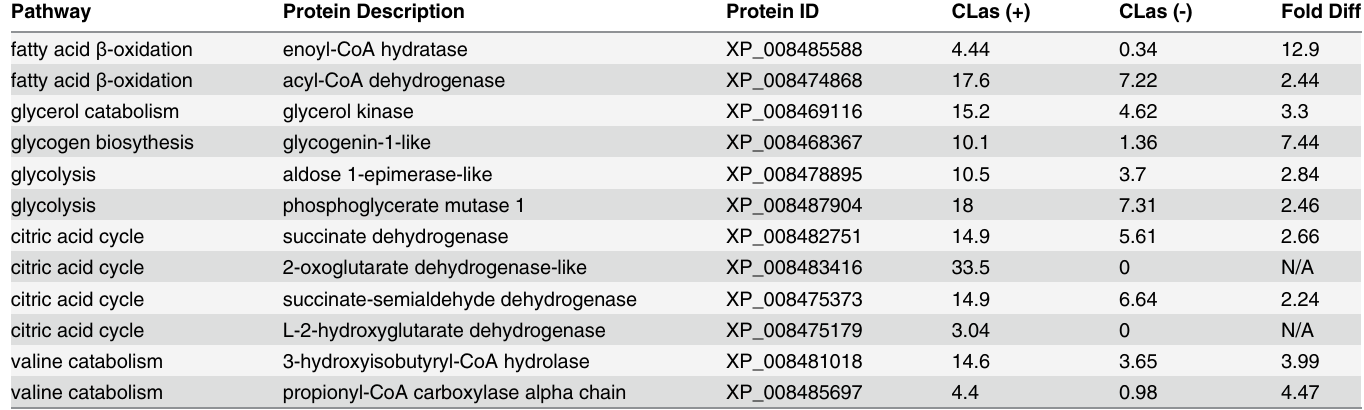
Table 2. Selected D . citri metabolism proteins upregulated in CLas(+) insects. Average normalized peptide count from specified proteins and fold differ- ence: CLas(+)/CLas(-).